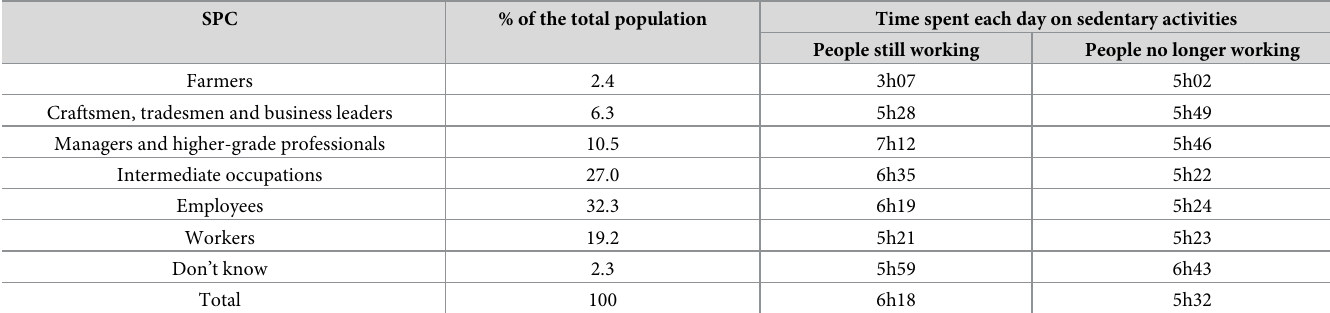
Table 8. Time spent each day on sedentary activities by